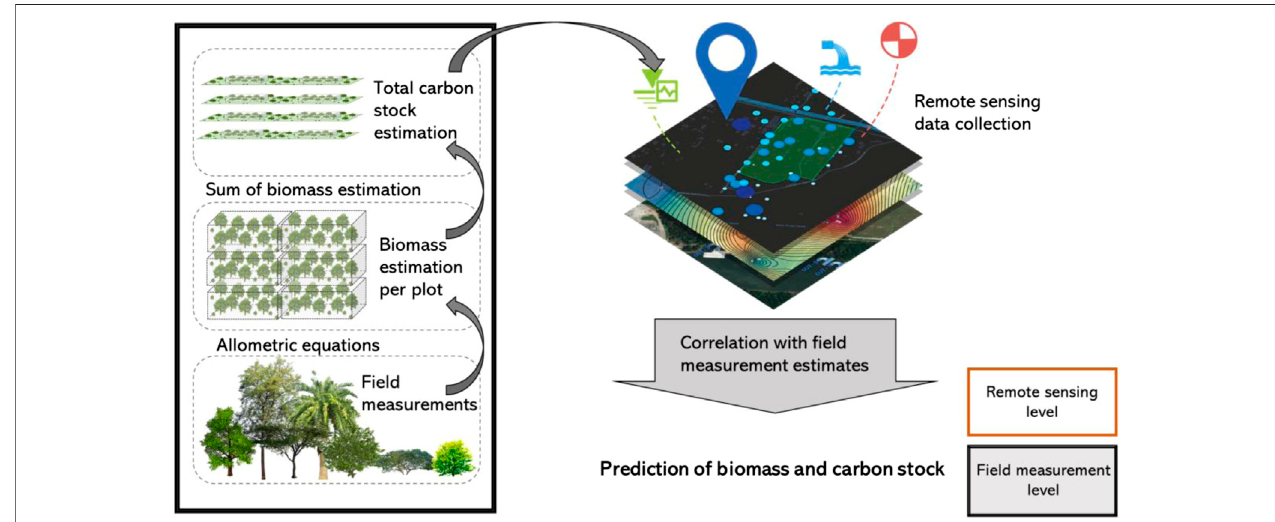
FIGURE 1 | The road map of the methodology applied in this